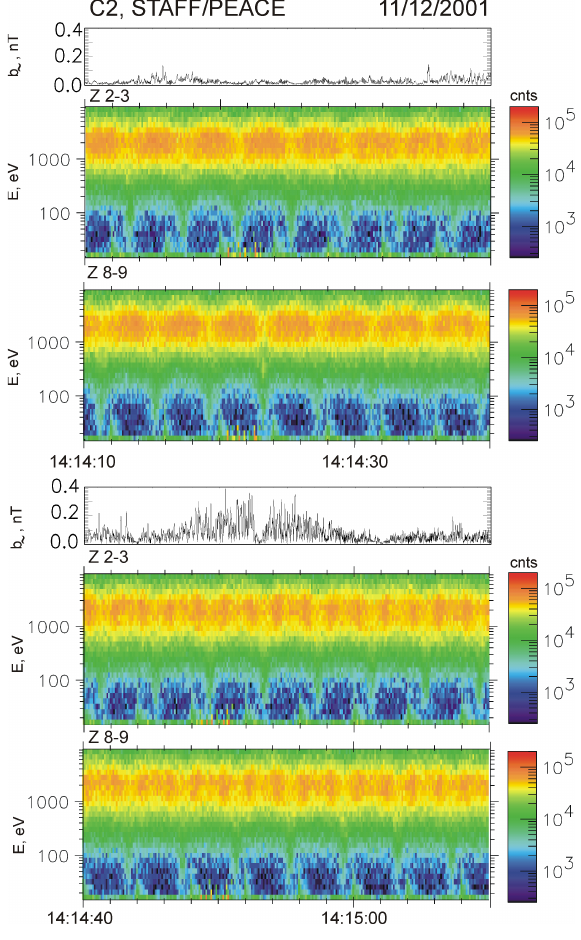
Fig. 5. Spectrogram of the electron fluxes (high resolution mea- surement) and the wave intensity measured onboard spacecraft 2.